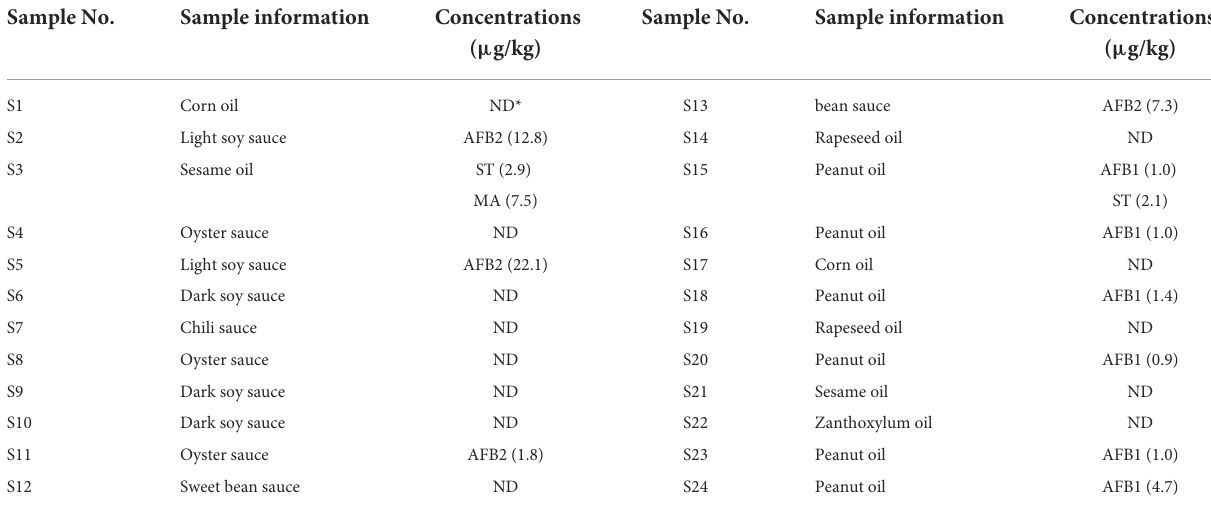
TABLE 5 Concentrations of mycotoxins detected in the condiments and oils. Sample